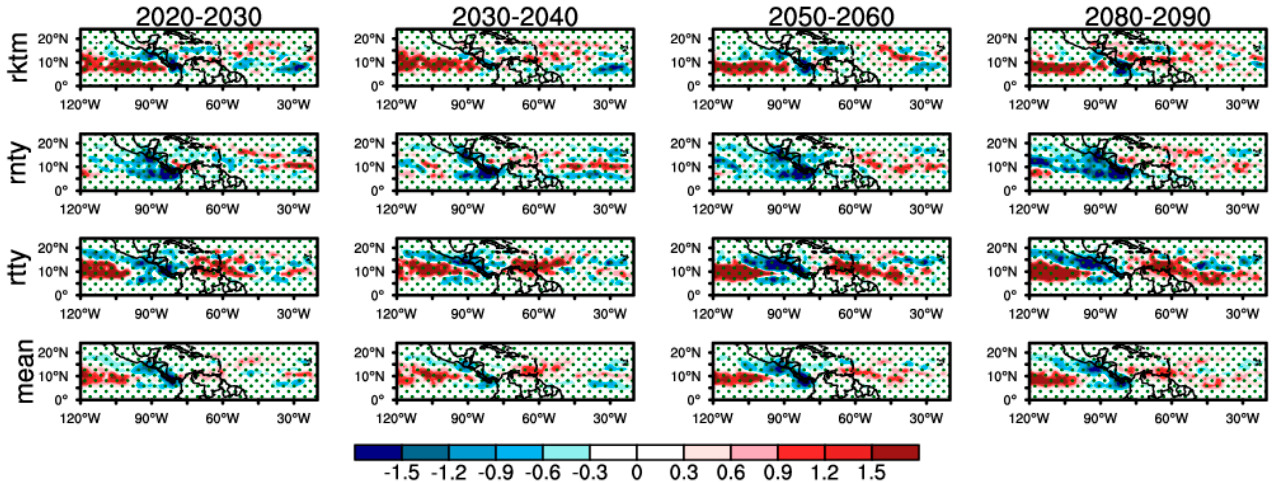
Figure 7. Mean annual anomalies of easterly wave track density in the future ensemble runs with respect to the reference period (1990–2000). The dotted regions indicate a 95% significance level applying the Kolmogorov–Smirnov two-sample test.